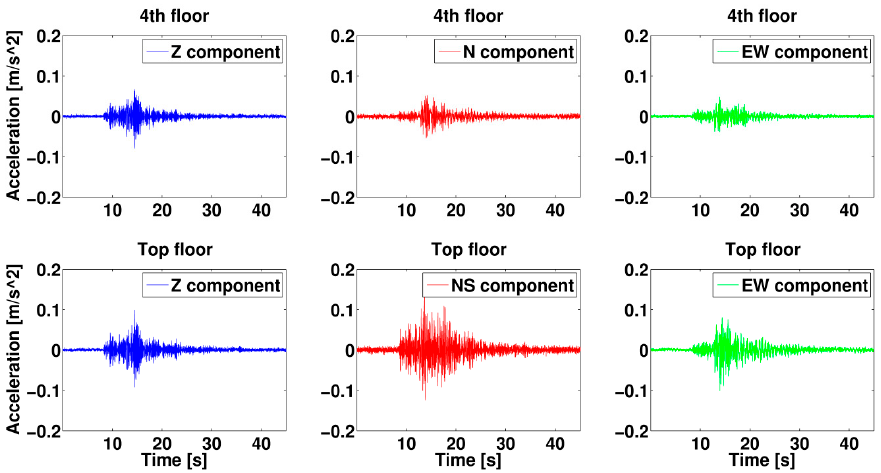
Figure 6. Earthquake data (11. October 2013 Volvi earthquake) for the east-west (EW), north-south (NS) and vertical (V) components recorded using MEMS sensors installed in a predecessor of the MPwise units (SOSEWIN, see [1]) deployed in the AHEPA hospital at the 4th floor and the roof.